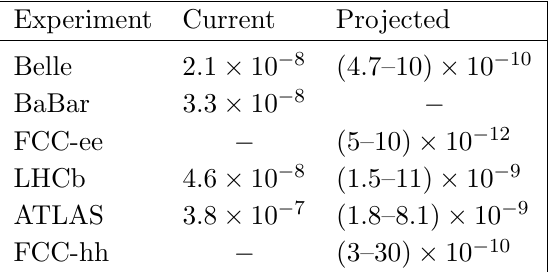
! (cid:22) (cid:7) (cid:6) (cid:22) (cid:7) (cid:22) (cid:7) branching fraction. The